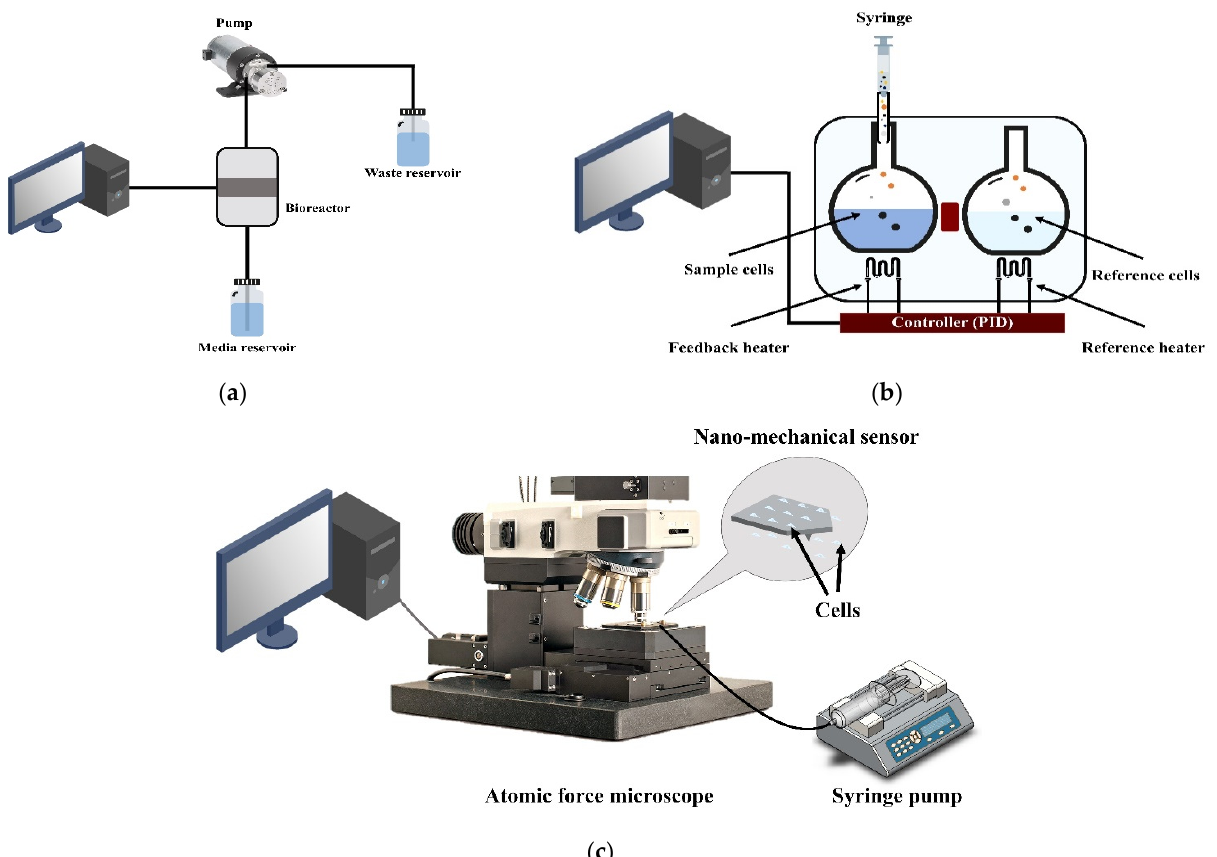
Figure 4. Mechanical measuring methods: ( a ) schematic of an online monitoring system based on respiration activity; ( b ) closed ampoule isothermal microcalorimetry; ( c ) nanomechanical oscillator sensor.